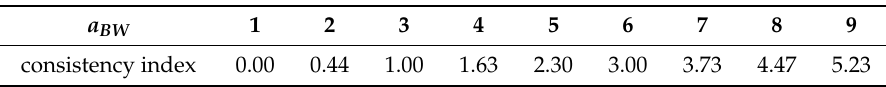
Table 2. Consistency